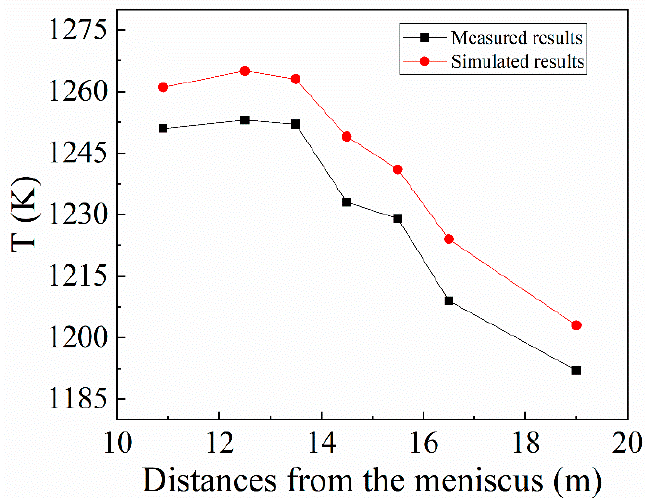
Figure 3. Comparison between the cast billet surface temperature simulation and measured results.